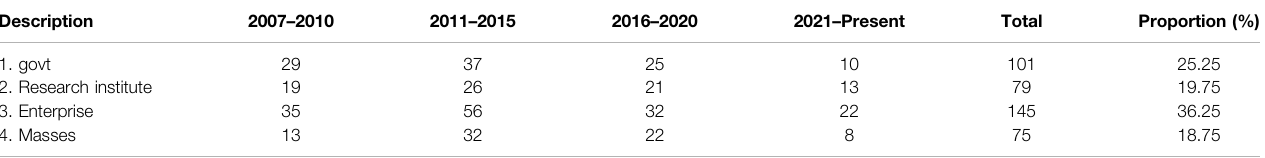
TABLE 2 | Distribution of policy implementation